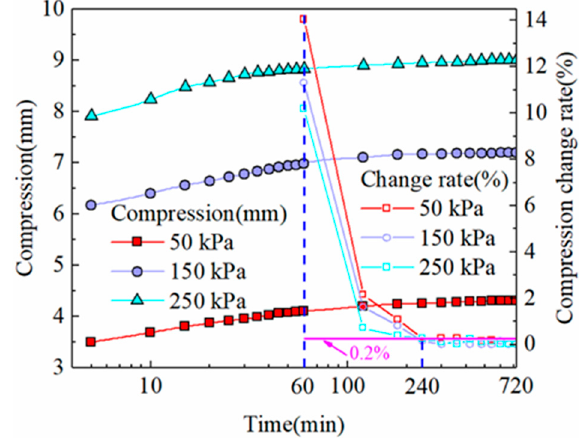
Figure 4. Compression characteristics in soybean bulk.